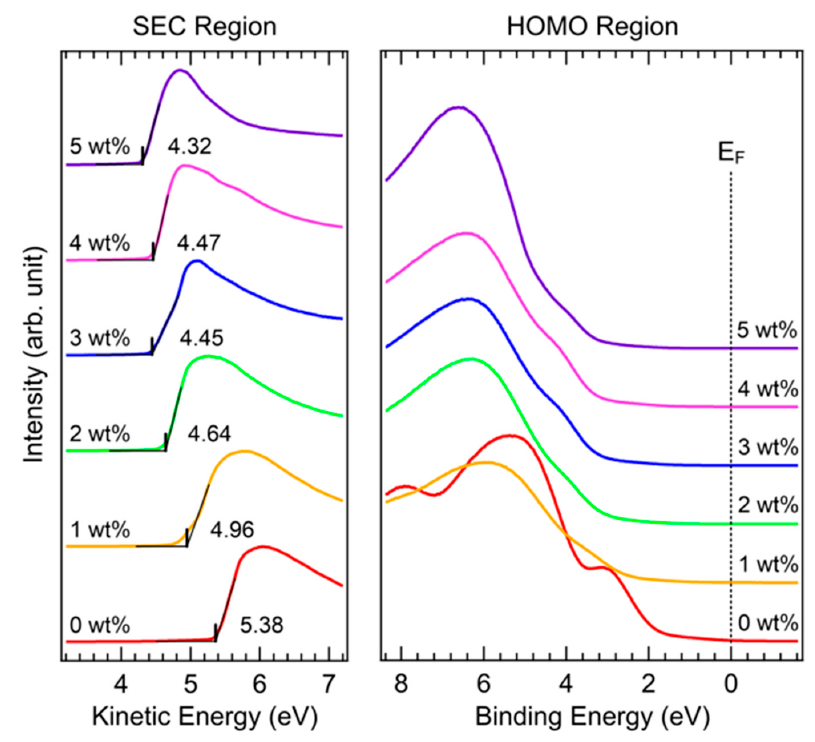
Figure 2. UPS spectra of SEC and HOMO regions of PEDOT:PSS films on ITO with various concen- trations of Brij C10 additive (0, 1, 2, 3, 4, and 5 wt%). XPS measurements were performed to investigate the core-level electronic structure.